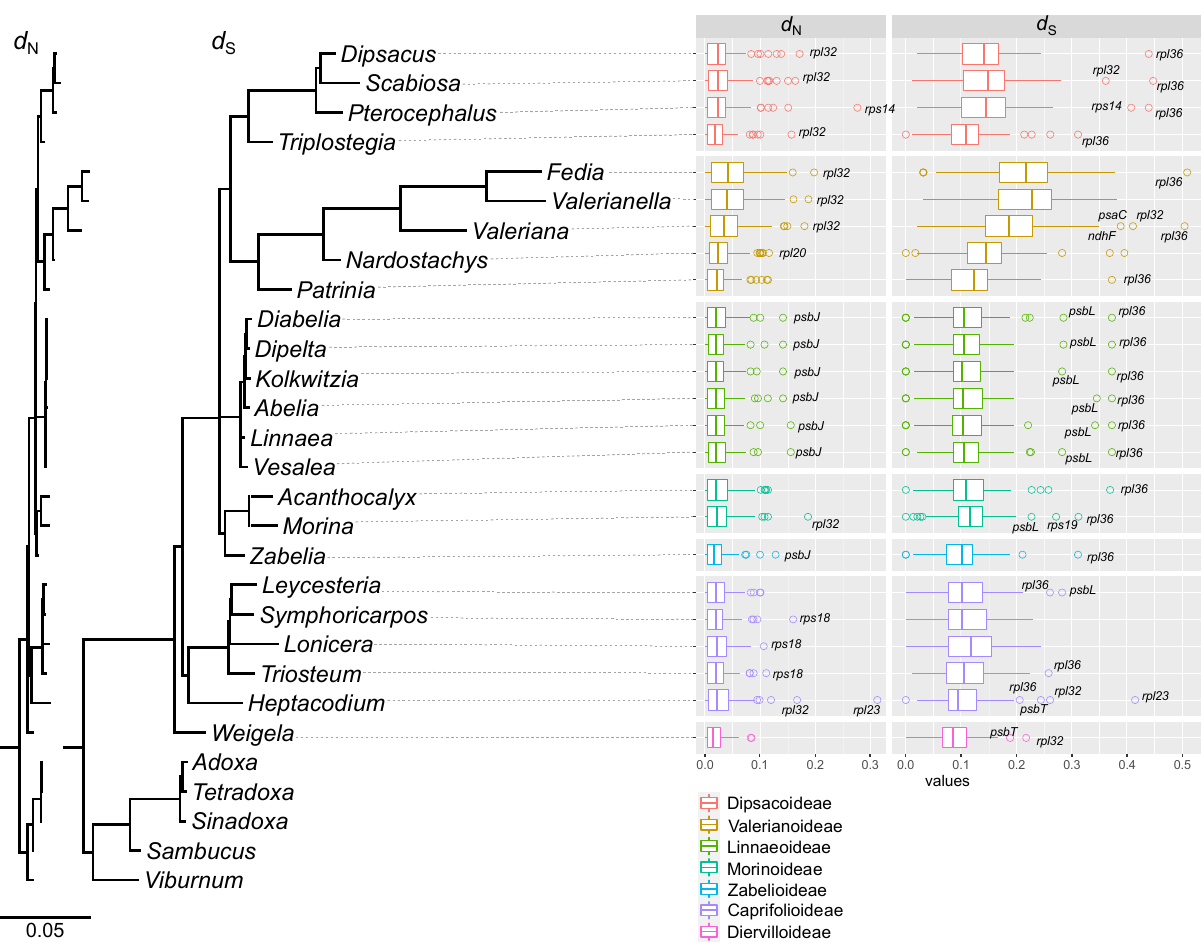
Figure 2. Plastid sequence divergence among the selected Caprifoliaceae s.l. Plastid phylograms of nonsynonymous ( d N ) and synonymous ( d S ) substitution rates based on 72 plastid genes. Boxplots of the values of d N and d S for individual genes. The box represents values between quartiles, solid lines extend to the minimum and maximum values, outliers are shown as circles and vertical lines in boxes show median values.